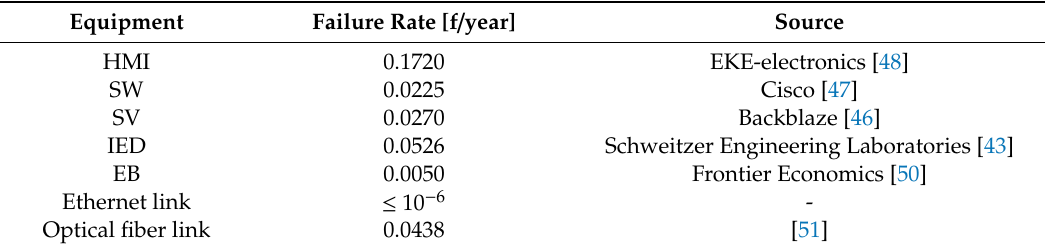
Table 6. Reliability values used in this work for each cyber-control